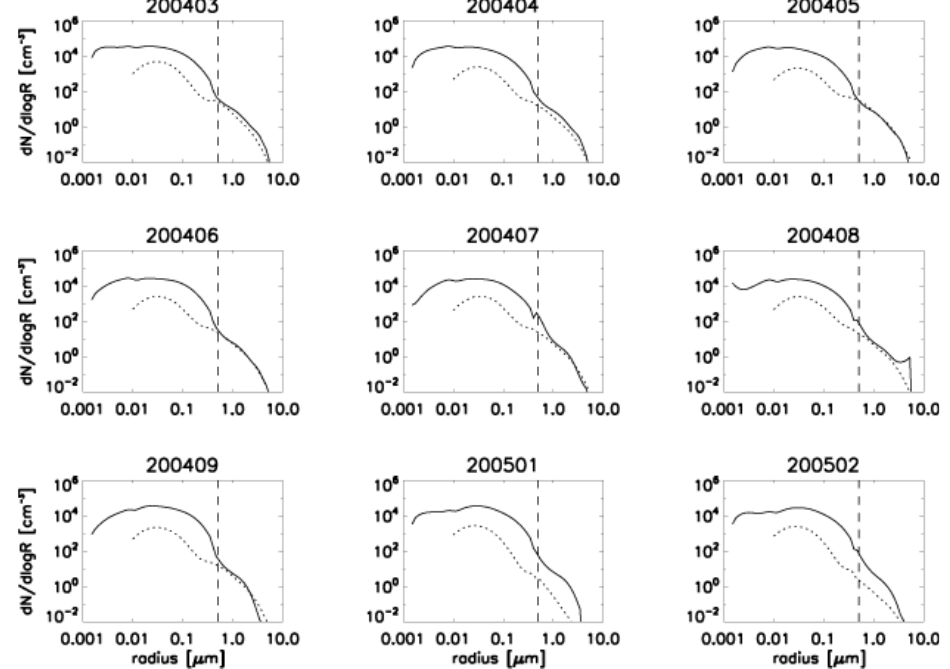
Fig. 3. Aerosol number size distribution in Beijing from March 2004 to February 2005. The solid line refers to the observations and the dotted line to the model results. The vertical dashed line is a separation between submicron and supermicron modes. Data in the last three months of year 2004 are too sparse to be included.